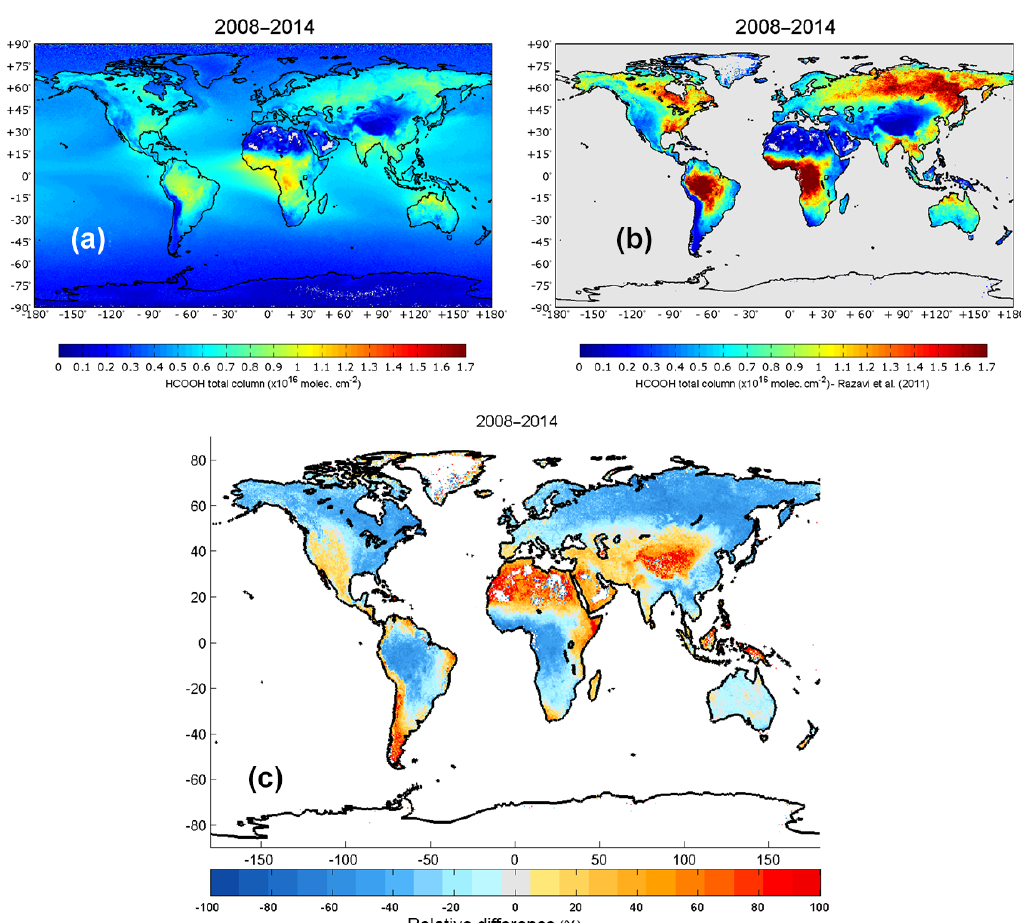
Figure 7. Mean HCOOH global distribution between 2008 and 2014, derived using the IASI radiance observations on a 0.5 ◦ × 0.5 ◦ grid with the retrieval from this work (a) , using the methodology described by Razavi et al. (2011) (b) , and the relative difference between both distributions in percent (c) . The relative difference is defined as (HCOOH this work – HCOOH Razavi et al. (2011) ) / HCOOH Razavi et al. (2011)